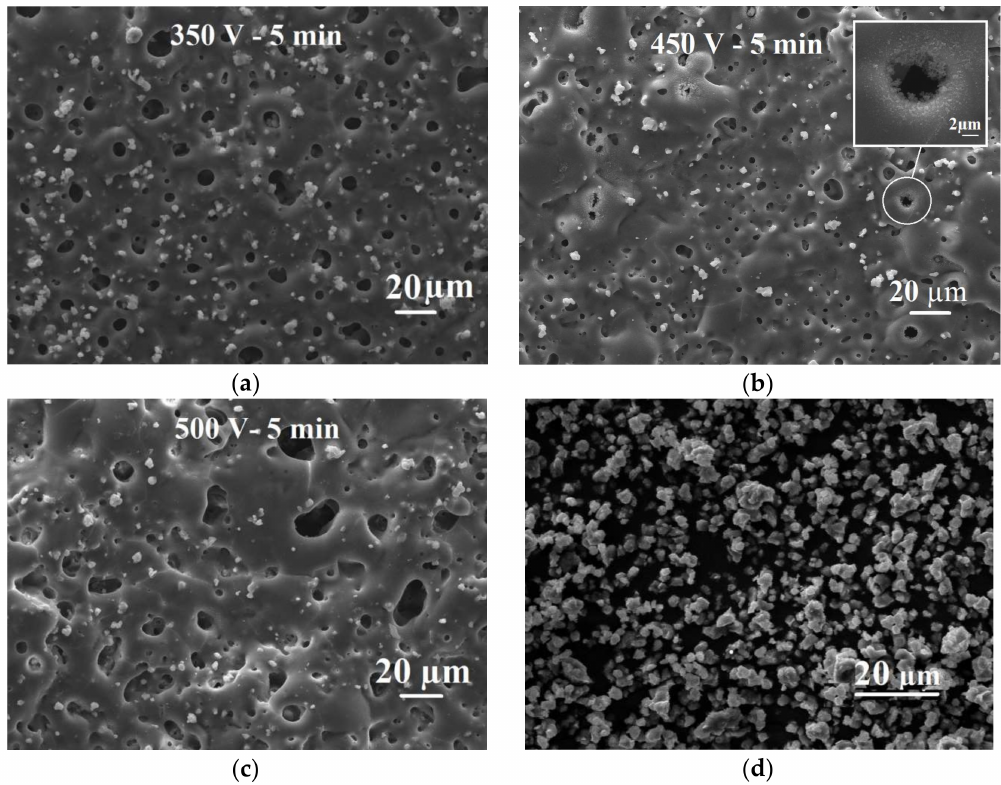
Figure 5. SEM micrographs of the surface of the CaP coatings deposited under different voltages ( a – c ) and of the β -tricalcium phosphate ( β -TCP) particles ( d